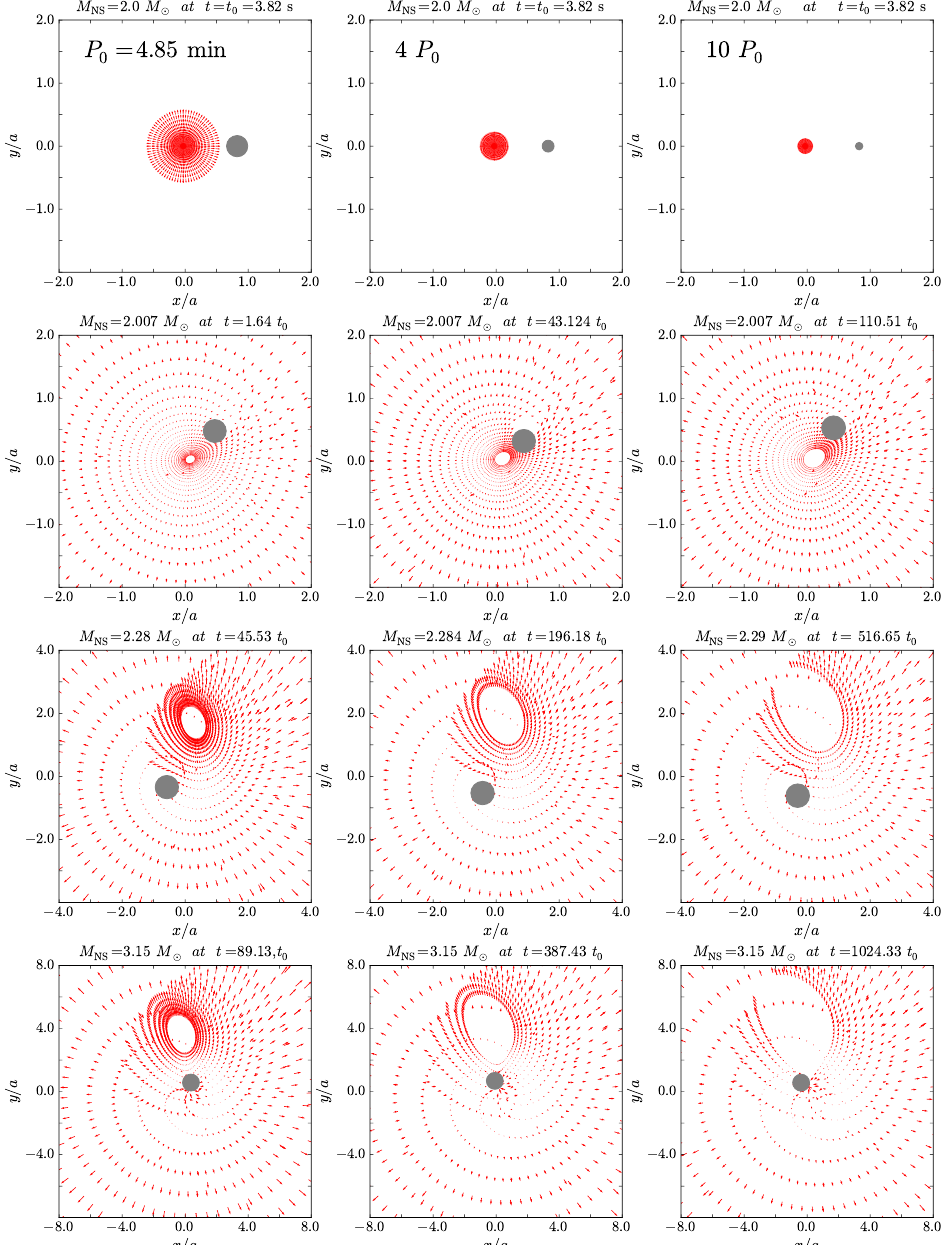
Figure 4. Numerical simulations of the SN ejecta velocity field (red arrows) at selected times of the accretion process onto the NS (taken from Figure 3 in [53]). In these snapshots we have adopted the CO core obtained from a M ZAMS = 30 M progenitor; an ejecta outermost layer velocity (cid:12) = 2 v 0 10 9 cm s − 1 , an initial NS mass, M NS ( t = t 0 ) = 2.0 M . The minimum orbital period to star × (cid:12) have no Roche-lobe overflow is P 0 = 4.85 min. In the left, central and right columns of snapshots we show the results for binary periods P = P 0 , 4 P 0 , and 10 P 0 , respectively. The Bondi-Hoyle surface, the filled gray circle, increases as the evolution continues mainly due to the increase of the NS mass (the decrease of the lower panels is only apparent due to the enlargement of the x-y scales). The x-y positions refer to the center-of-mass reference frame. The last image in each column corresponds to the instant when the NS reaches the critical mass value. For the initial conditions of these simulations, the NS ends its evolution at the mass-shedding limit with a maximum value of the angular momentum J = 6.14 10 49 g cm 2 s − 1 and a corresponding critical mass of 3.15 M × (cid:12)